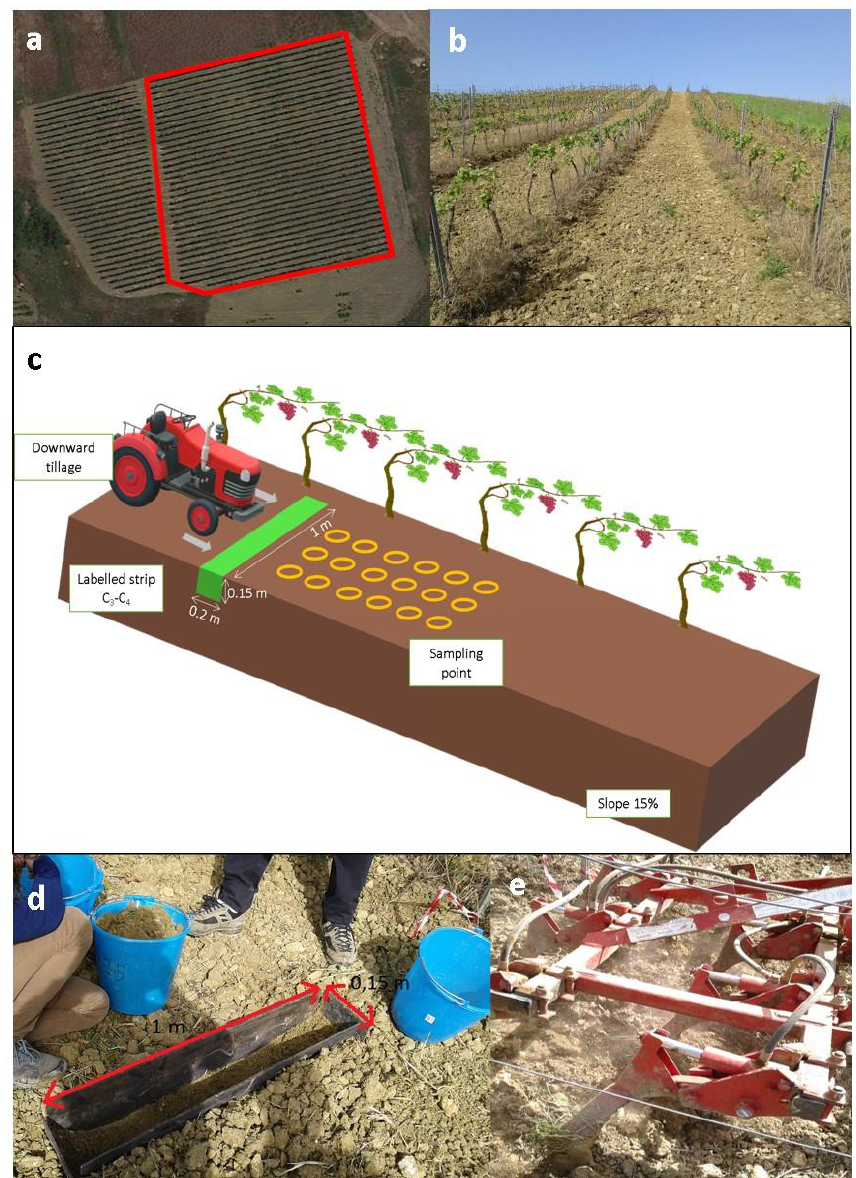
Figure 1. Representation of field experiment: ( a ) study area (Google Earth image); ( b ) inter-row of the selected vineyard; ( c ) schematic representation of field experiment and sampling points; ( d ) installation of the labelled isotopic strip; ( e ) cultivator used for tillage operation.